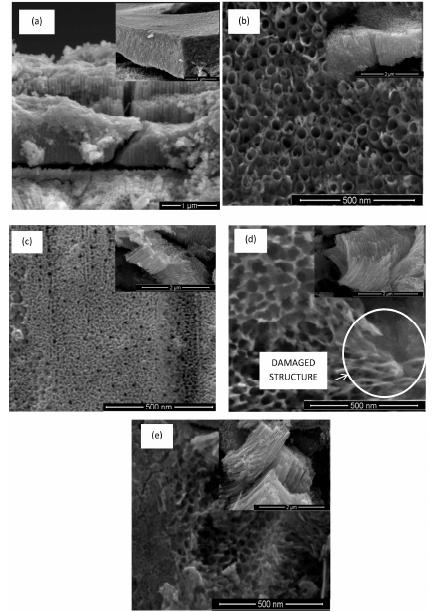
Figure 1. Scanning electron microscopy (SEM) images of TiO 2 NTs for ( a ) Cu ‐ 00; ( b ) Cu ‐ 01; ( c ) Cu ‐ 02; ( d ) Cu ‐ 03, and ( e ) Cu ‐ 04. Table 2. Geometrical dimension of all samples.